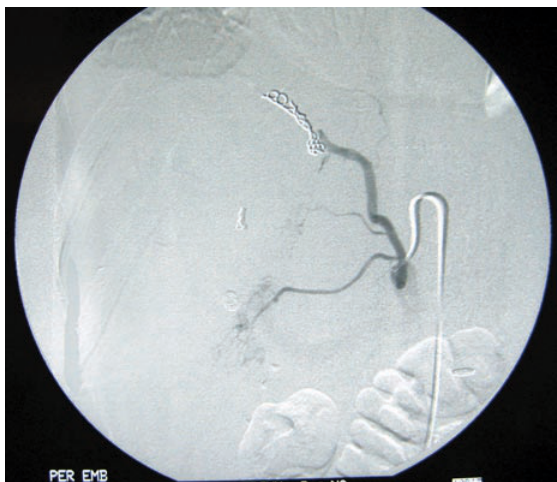
Figure 6. Hepatic